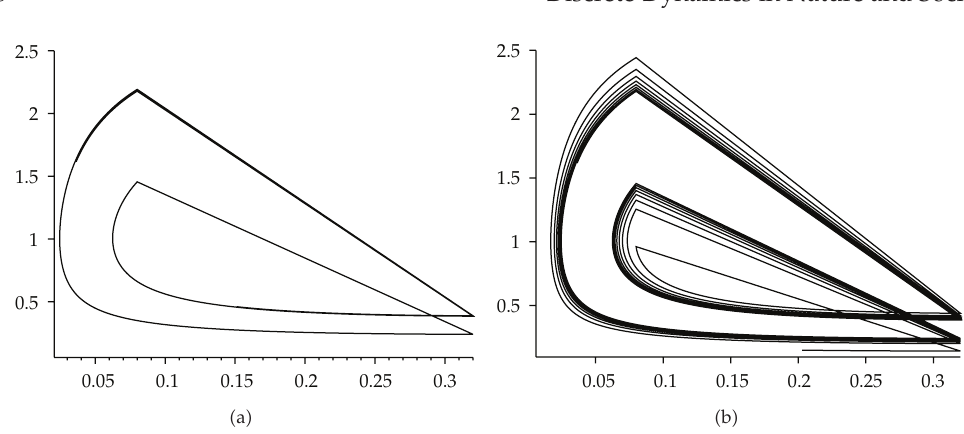
Figure 5: (cid:9) a (cid:10) Existence of positive period-2 solution; (cid:9) b (cid:10) stability of positive period-2